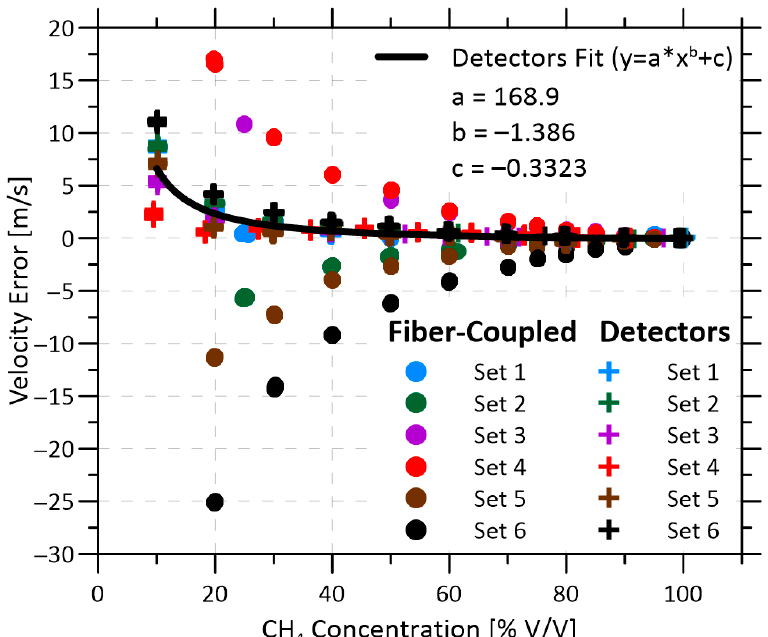
Figure 6. Velocity error as a function of methane volume fraction collected over six different tests